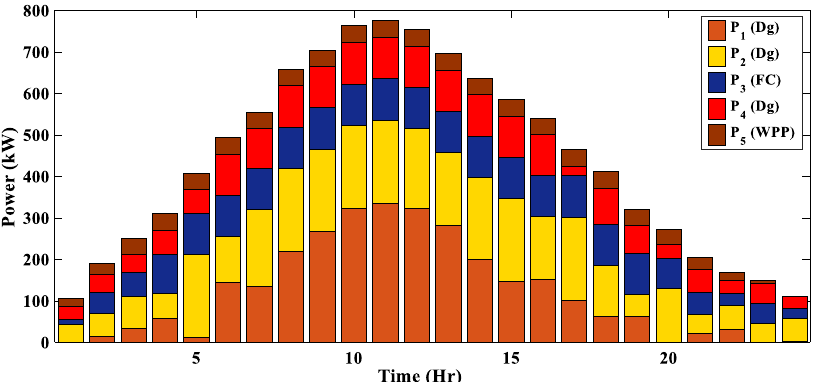
Figure 5. The generation scheduling of MSCHPEED with REI for cost minimization.